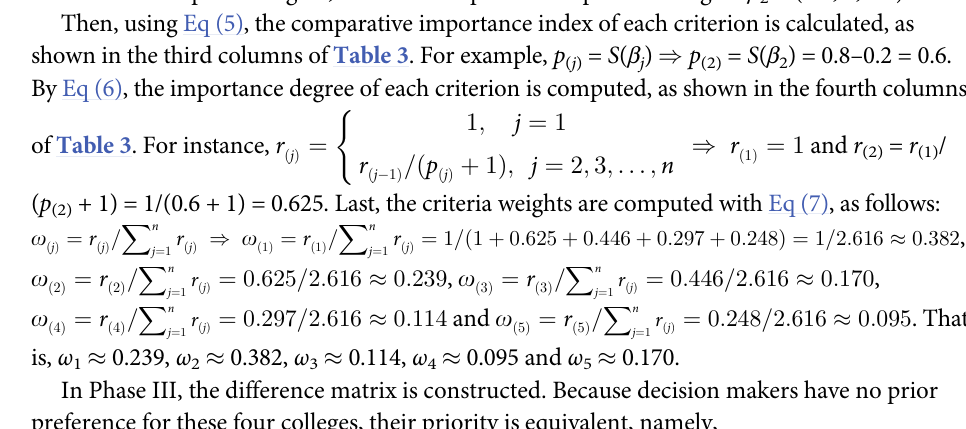
ffiffiffiffiffiffiffiffiffi p ffiffiffiffiffiffiffiffiffi 0 : 26